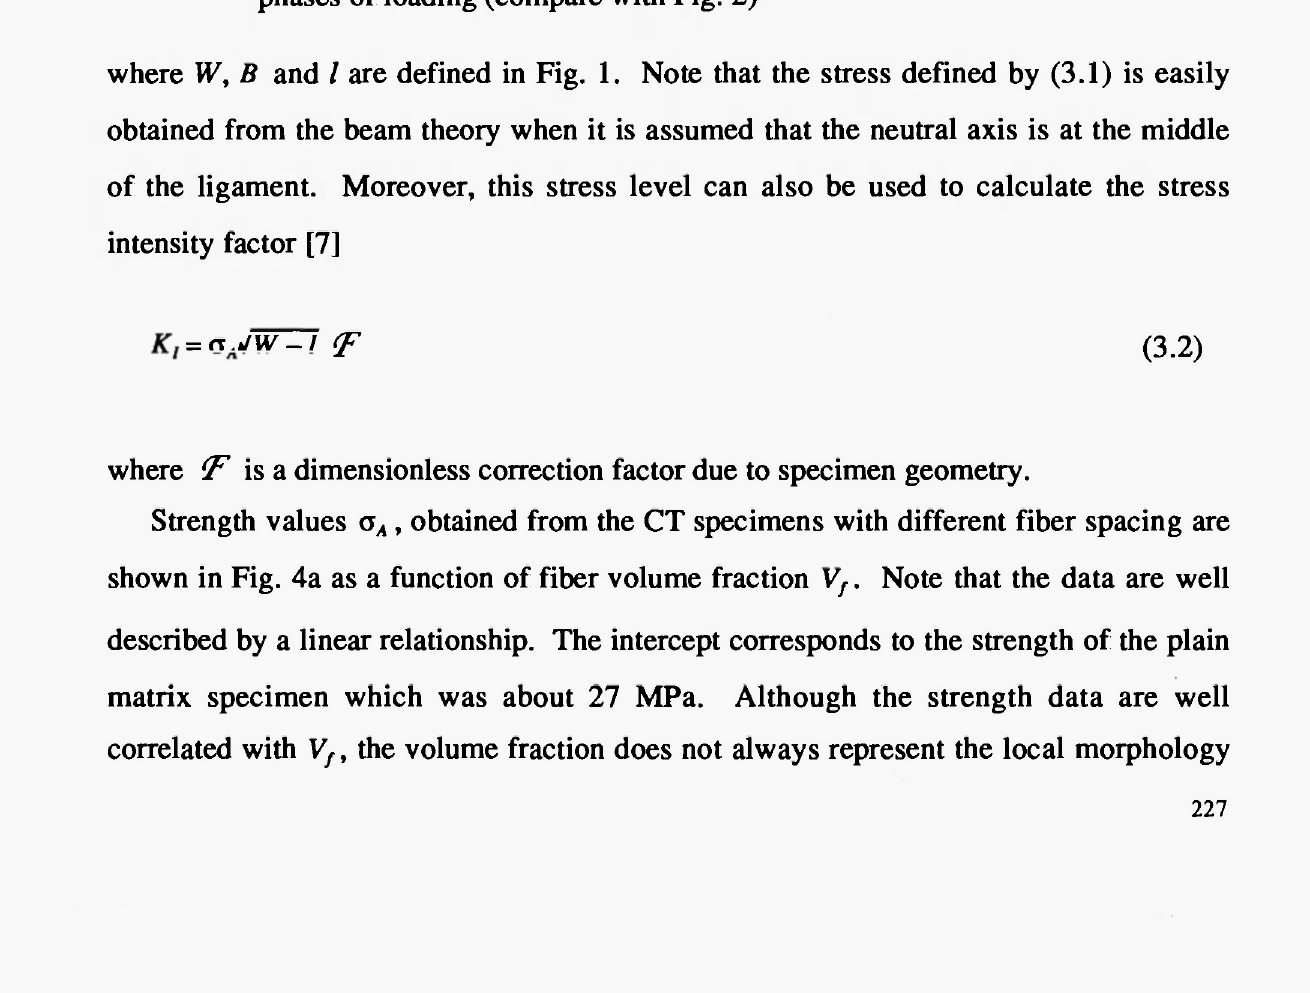
Fig. 3: Photographs indicating the morphology of fracture at consecutive phases of loading (compare with Fig.